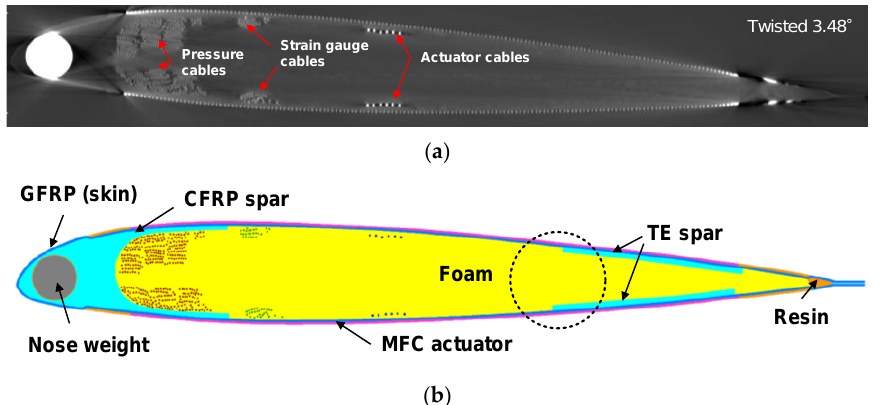
Figure 6. Comparison of section images at blade airfoil station U2. ( a ) X-ray scan image and ( b ) section-segmented image.